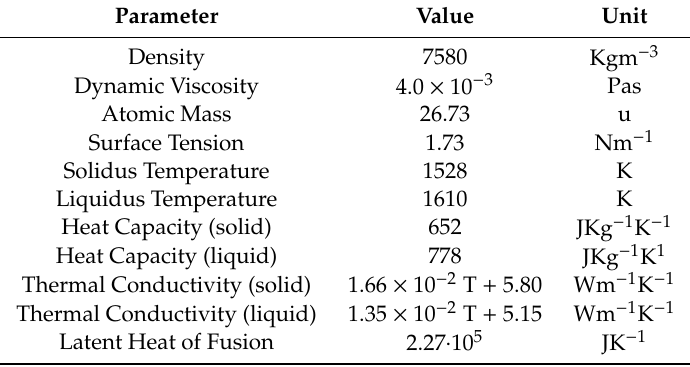
Figure 2. ( a ) Schematic of the simulation domain. The temperature field and the melt pool shape are shown. For convenience, the whole domain (width 15 mm) is not illustrated. The beam’s hatch pattern is schematically shown. ( b ) Schematic illustration of the solidification directions within overlapping melt pools. The maximum angle between thermal gradient G (proportional to the solidification velocity v s ) and the BD, ϕ int , is reached at the interface between two layers, while ϕ int is about 0 ◦ at the bottom of the next layer. Table 3. Material parameters for IN718 used in S AM PLE 2D [15–17]. The thermal conductivity in the solid and the liquid are linearly approximated with the temperature (T) in K.